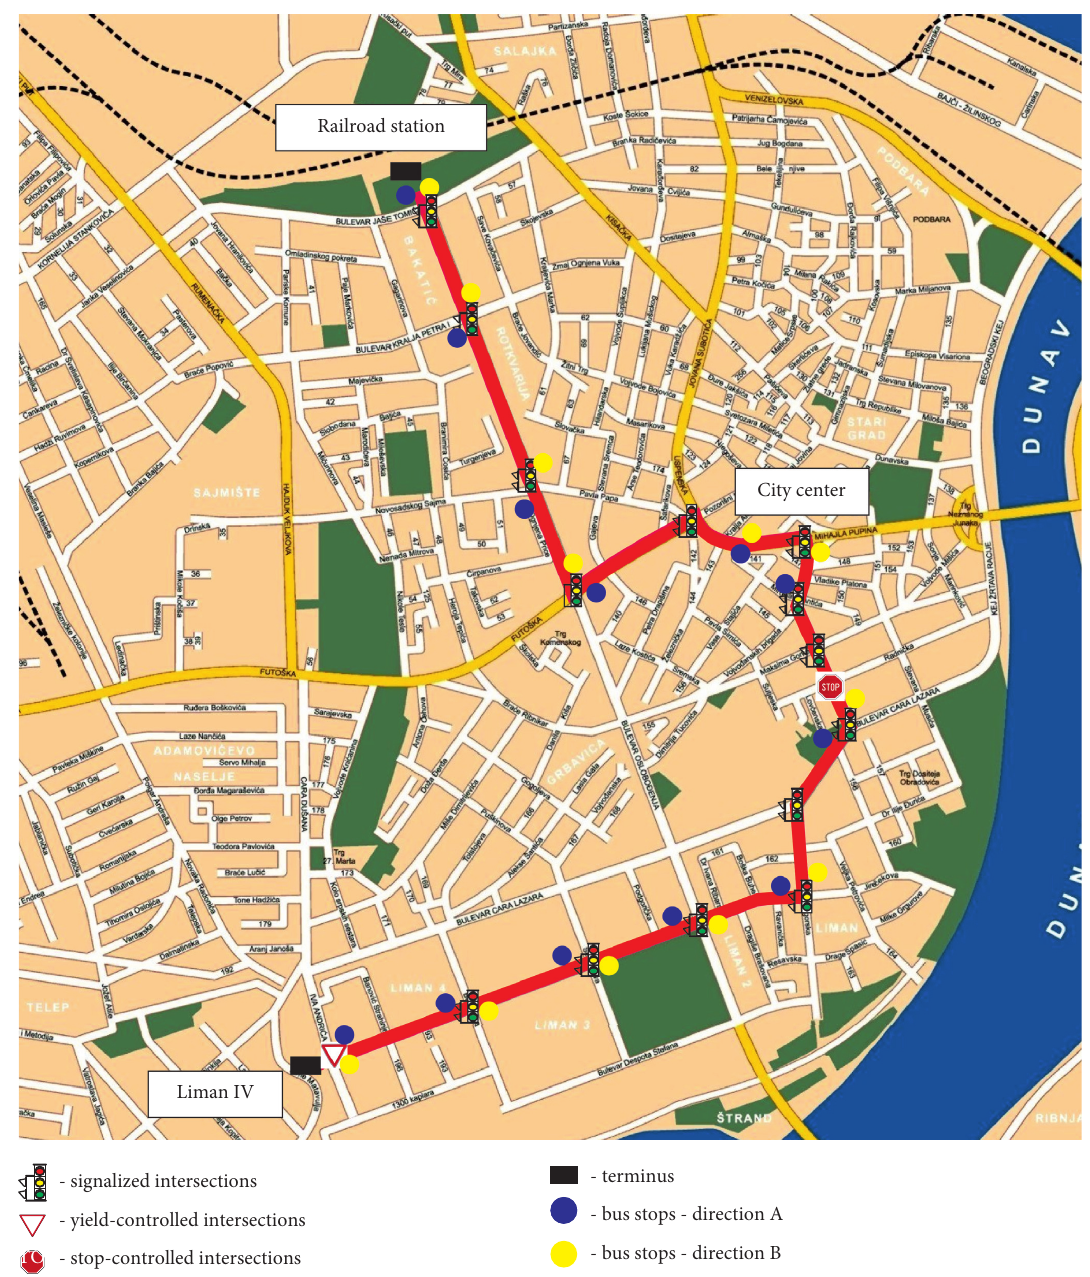
Figure 4: Horizontal view of the line 4